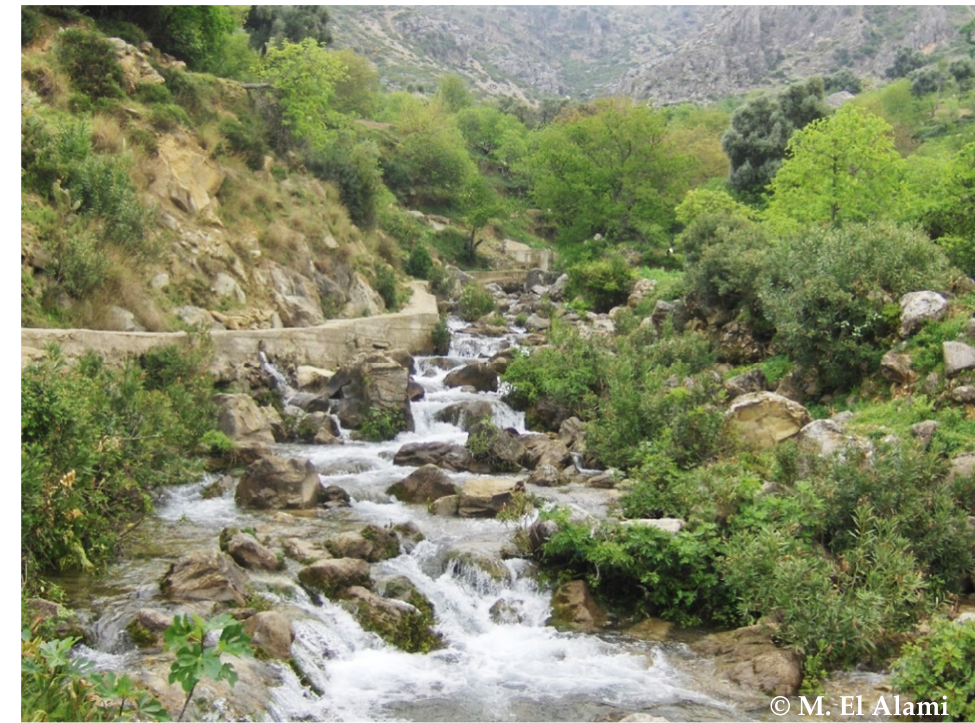
Figure 2. Oued Maggo a typical habitat of Epeorus cf. torrentium . Rhithrogena